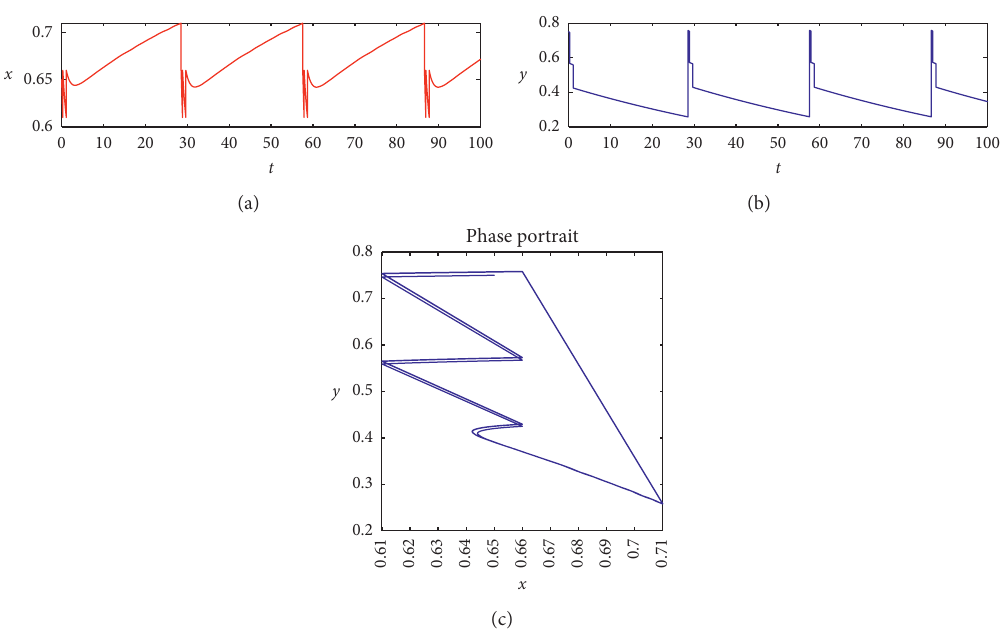
Figure 11: The order-3 periodic orbit of system (12). Control parameters: p � 0.6 and τ � 0.5.